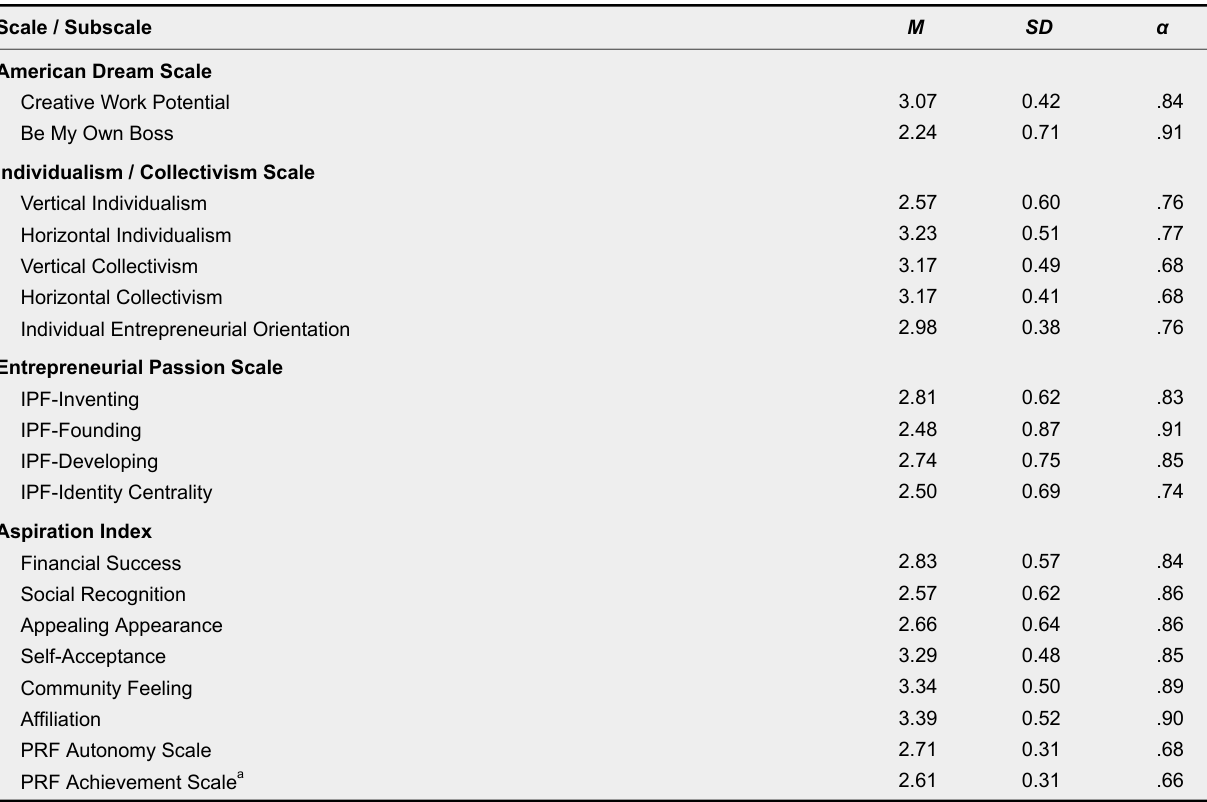
Means, Standard Deviations, and Reliabilities for Scales and Subscales (Study 2b, N =